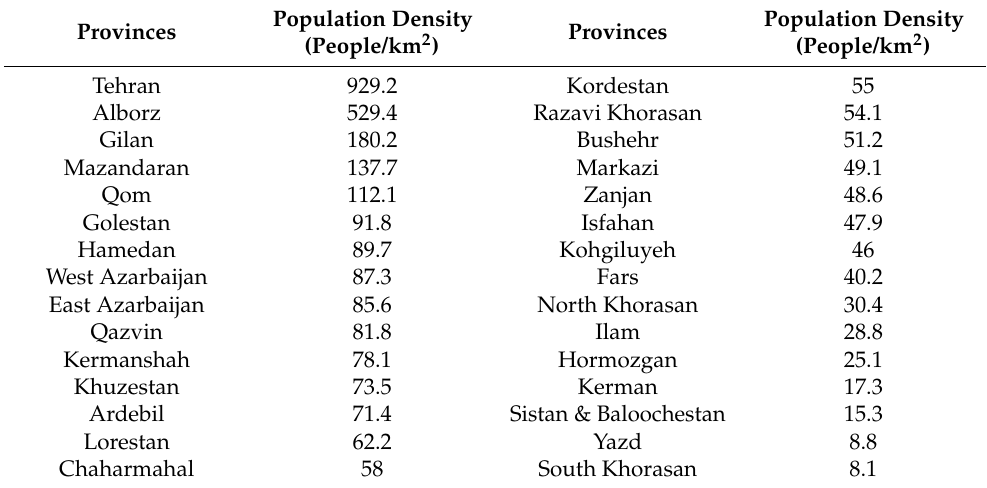
Table 6. Population density in Iran for each province (produced by the Iran Census Center for 2016).